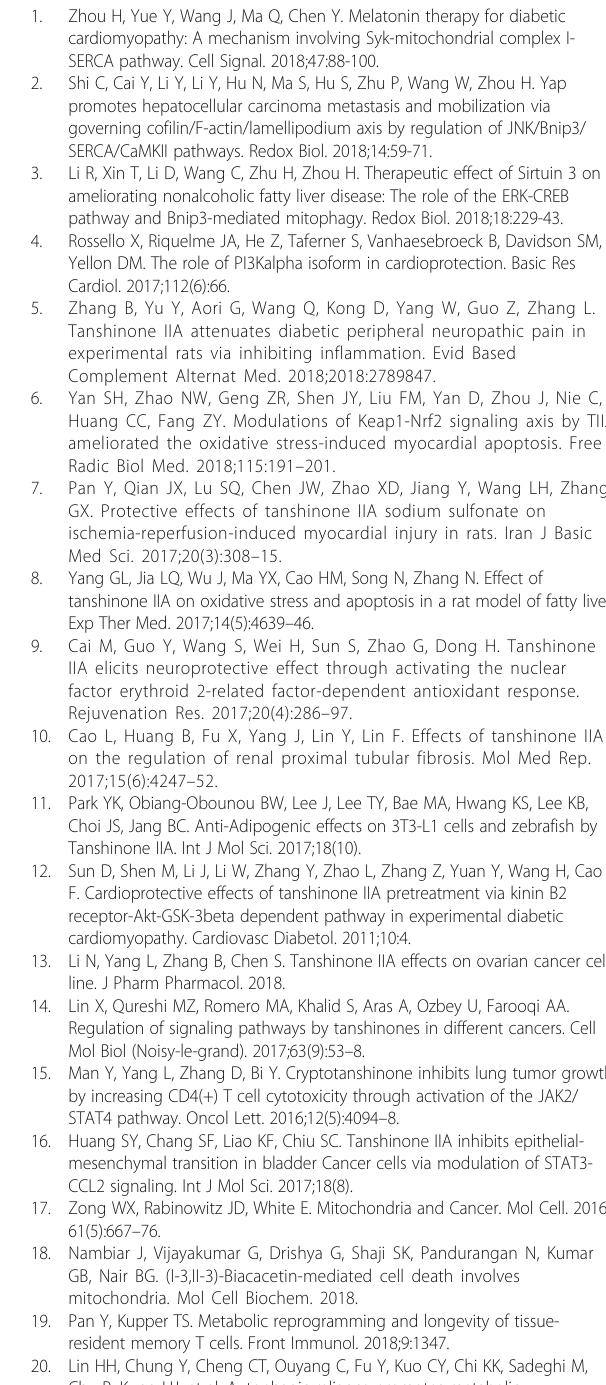
Additional file 1: Figure S1. A-B. MTT assay in SW837 cells and SW480 cells. Different doses of Tan IIA was used to incubate with cancer cells and then cell viability was determined via MTT assay. C-D. The expression of Drp1 in response to Drp1 siRNA. * p <0.05 vs. control group; # p < 0.05 vs. Tan IIA +si-cont group. (DOCX 133